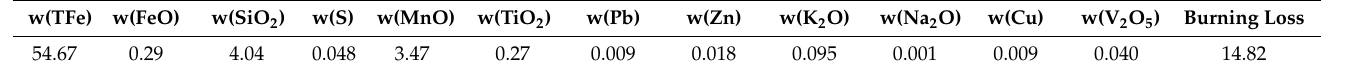
Figure 3. SEM of Guisha limonite: ( a ) 150×, ( b ) 2000×, ( c ) 5000×, ( d )10,000×.